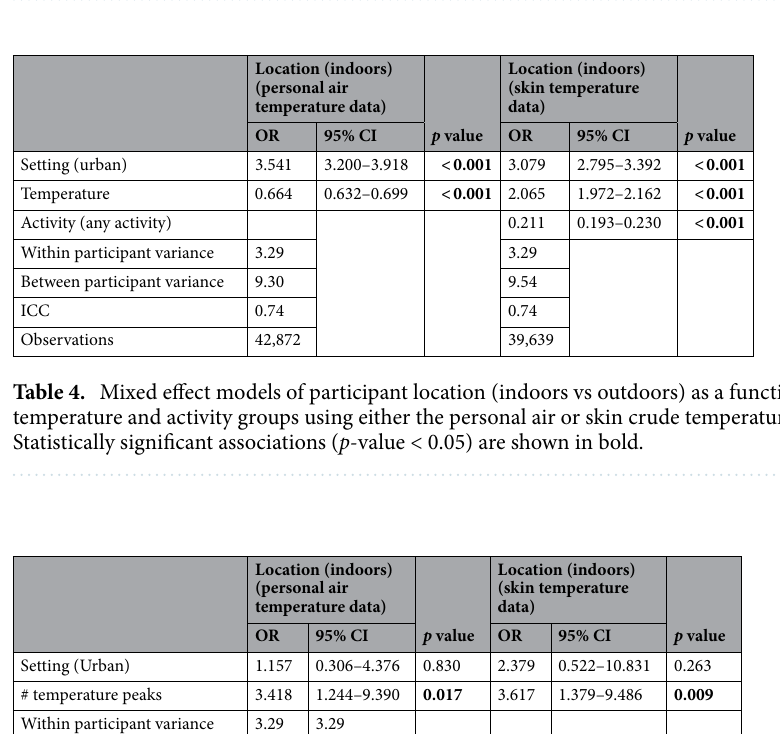
Table 3. Wearable sensor-based air and skin temperature diurnal variation, number of peaks and activity measurements stratified by location (indoors or outdoors). 1 Activity based on skin temperature sensor. *Based on the Wilcoxon rank sum test.